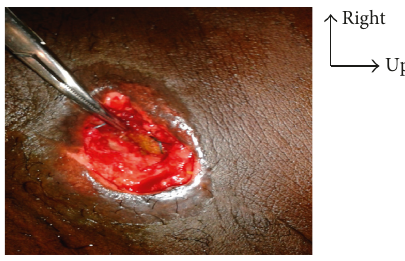
Figure 2: Parietal prosthesis visible through the wound.